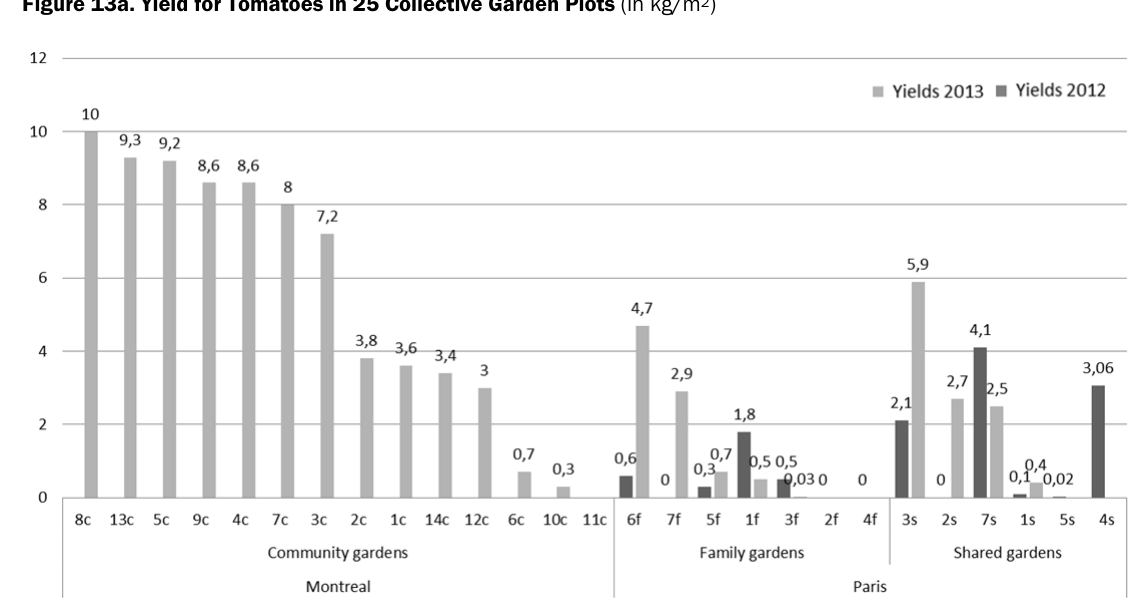
Figure 13a. Yield for Tomatoes in 25 Collective Garden Plots (in kg/m 2 )